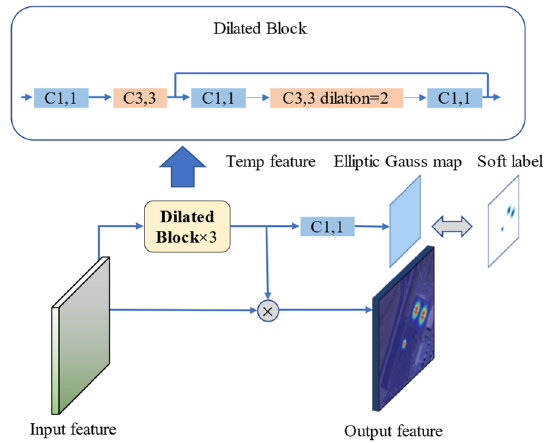
Figure 5. Channel attention module.